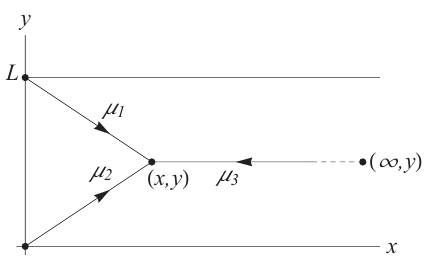
Figure 1: The three distinct points for the eigenfunctions μ j , j = 1, 2,